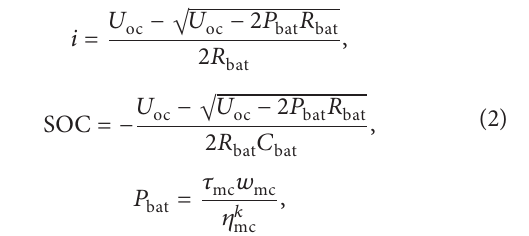
capable of obtaining the global optimum [8]. Compared with other kinds of derivative-free algorithms such as DIRECT, simulated annealing (SA), and genetic algorithm (GA), PSO’s strength lies in its simplicity, being easily coded and requiring few algorithm parameters to define convergence